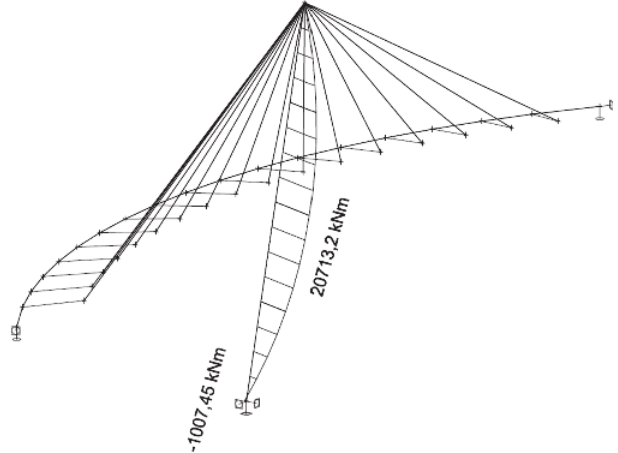
Bending moment on pylon (P): internal case